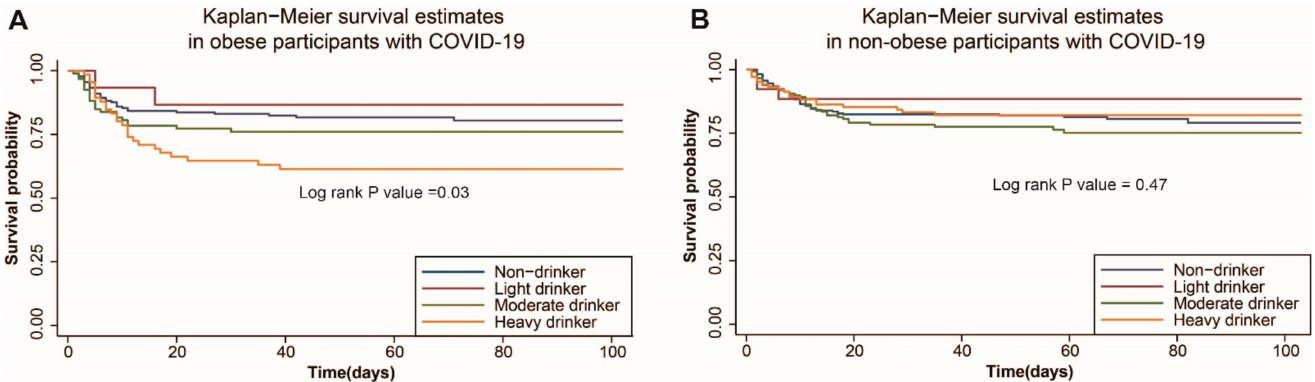
Figure 3. Survival probability of COVID-19 positive patient based on different drinking status in obese ( A ) and non-obese ( B )